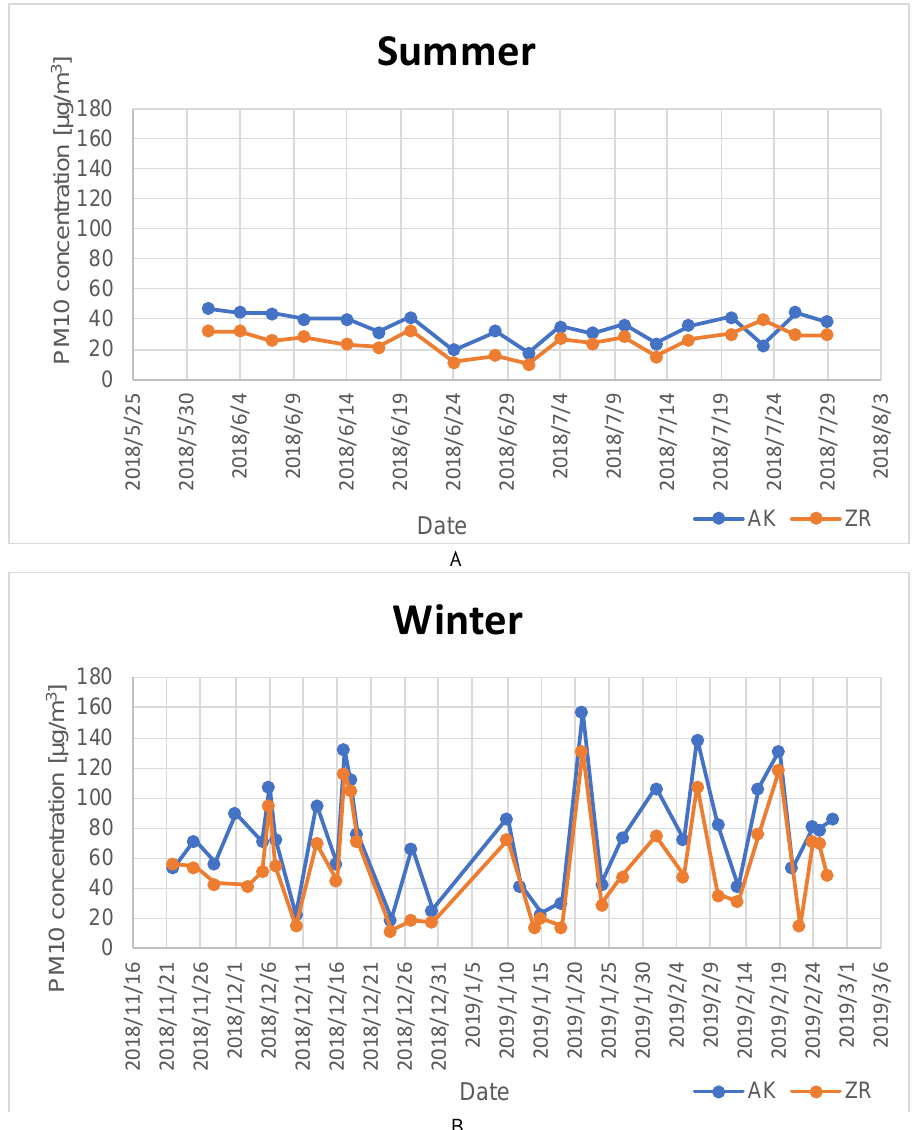
Figure 3. Variations of PM10 concentrations recorded at traffic-dominated (AK) and urban-background (ZR) sites during ( A ) summer and ( B ) winter season.